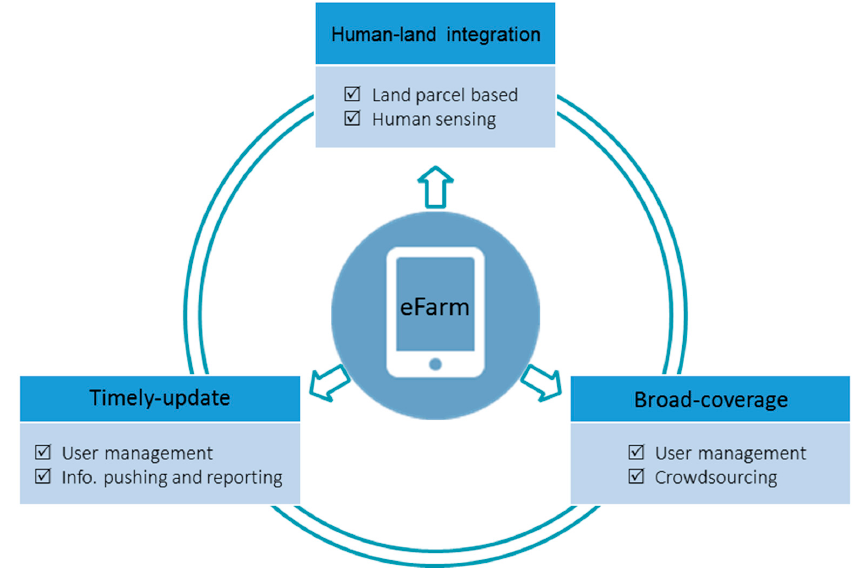
Figure 6. Solutions from eFarm for improving the observation of ALS.